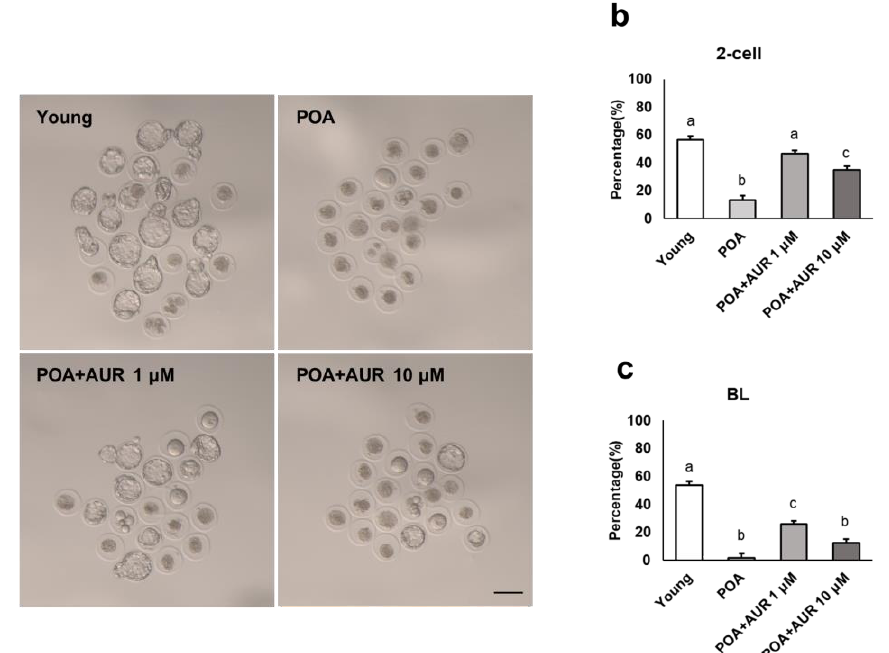
Figure 6. AUR promoted the fertilization and preimplantation development of postovulatory aged oocytes. ( a ) Representative images of blastocysts from young, aged and AUR-treated aged oocytes. Scale bar = 100 μm. ( b , c ) Quantitative analysis of embryo 2-cell and blastocyst formation rates. Data are presented as the means ± SEMs of at least three independent experiments. Significant difference indicated by lowercase letters of the alphabet, p < 0.01.